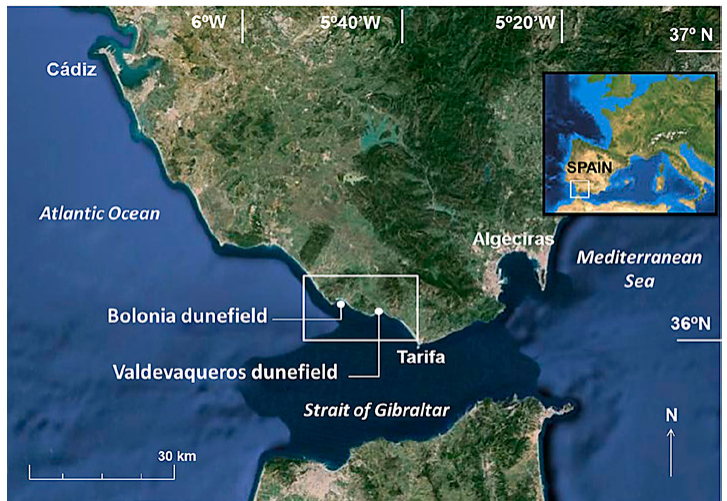
Fig. 1. – Location of the dunefields